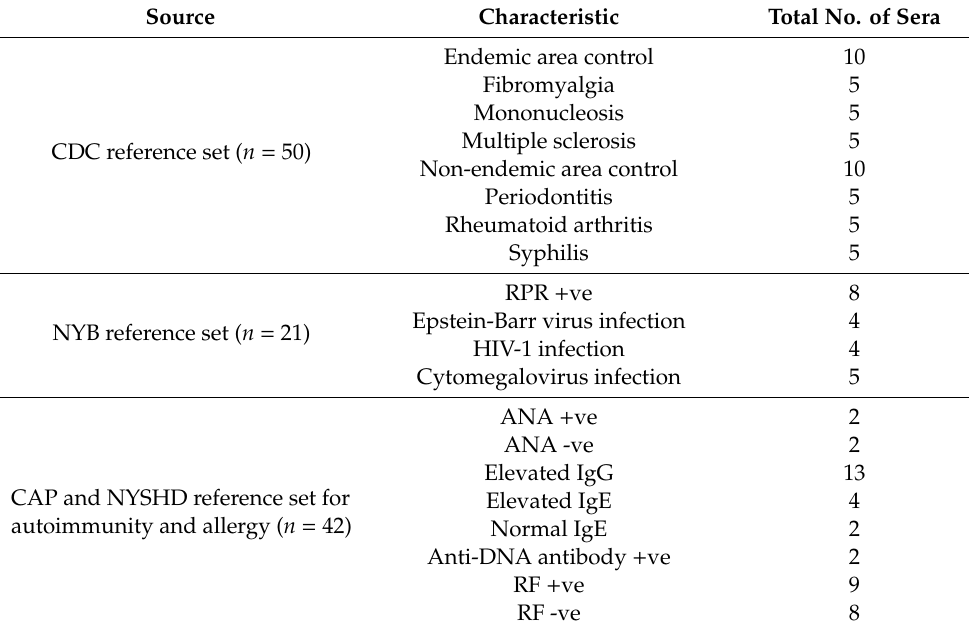
Table 1. Referencehumanserafordeterminingthespecificityofthetick-bornerelapsingfeverimmunoblots (TBRF IBs).